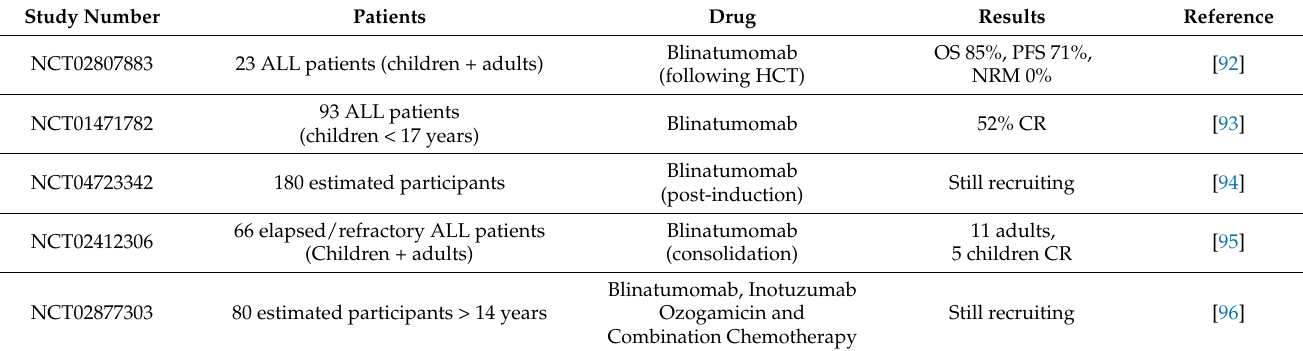
Table 3. Blinatumomab